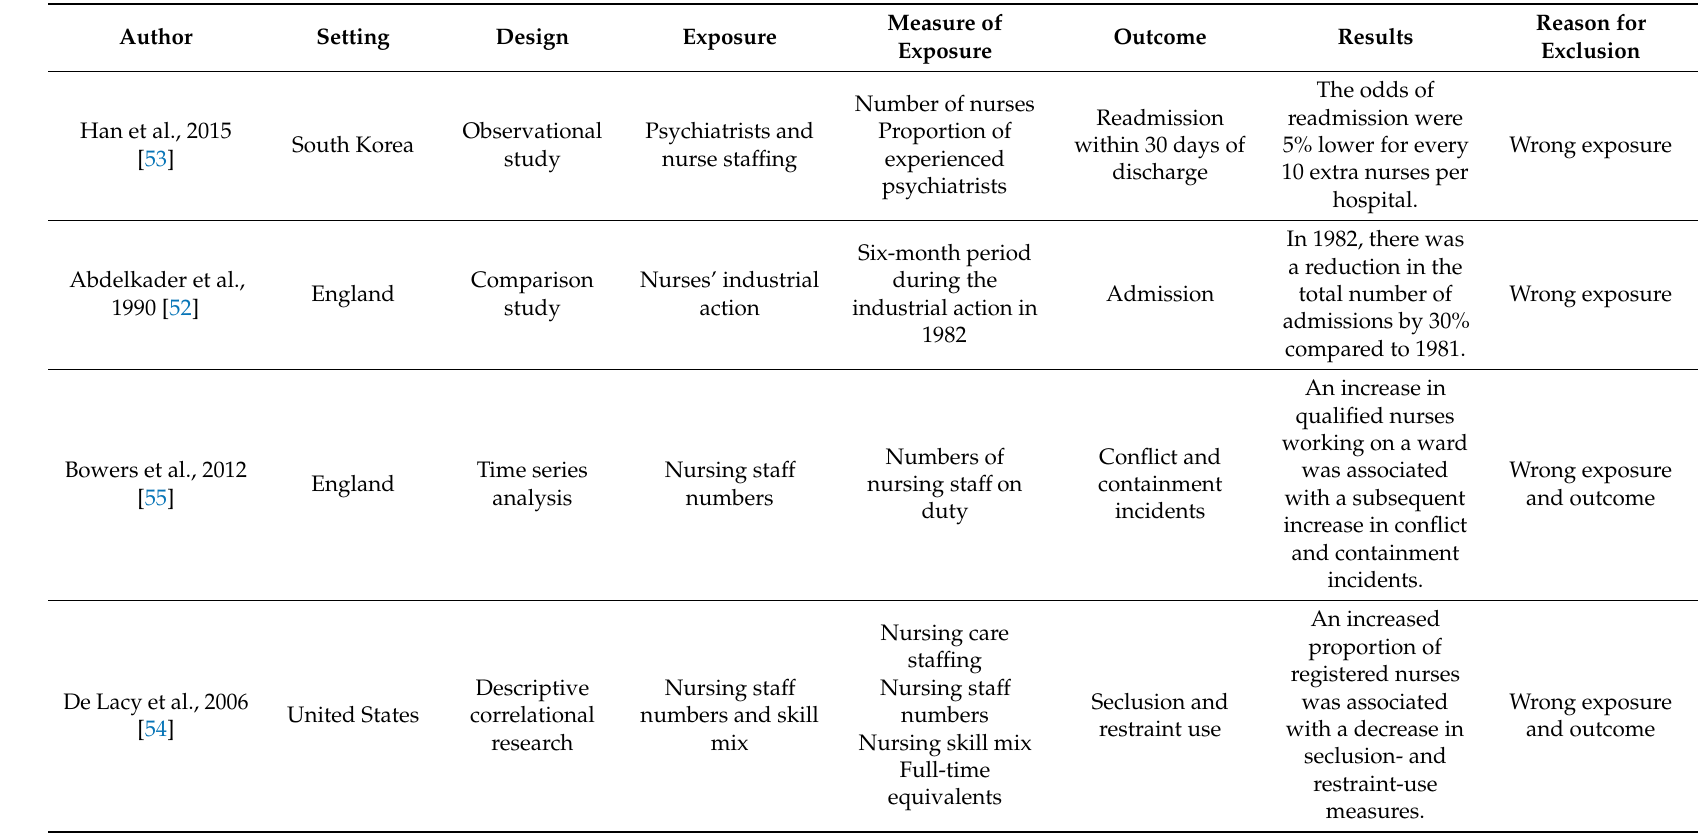
Table 2. Summary of the studies excluded at full-text